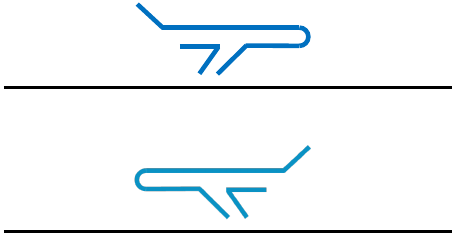
Figure 11. Lack of interdependency between two consecutive flight level